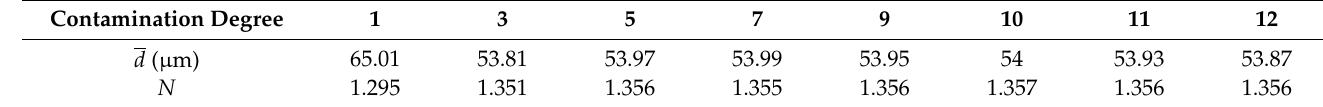
0.07mm Figure 8. The velocity under different deflector displacement.